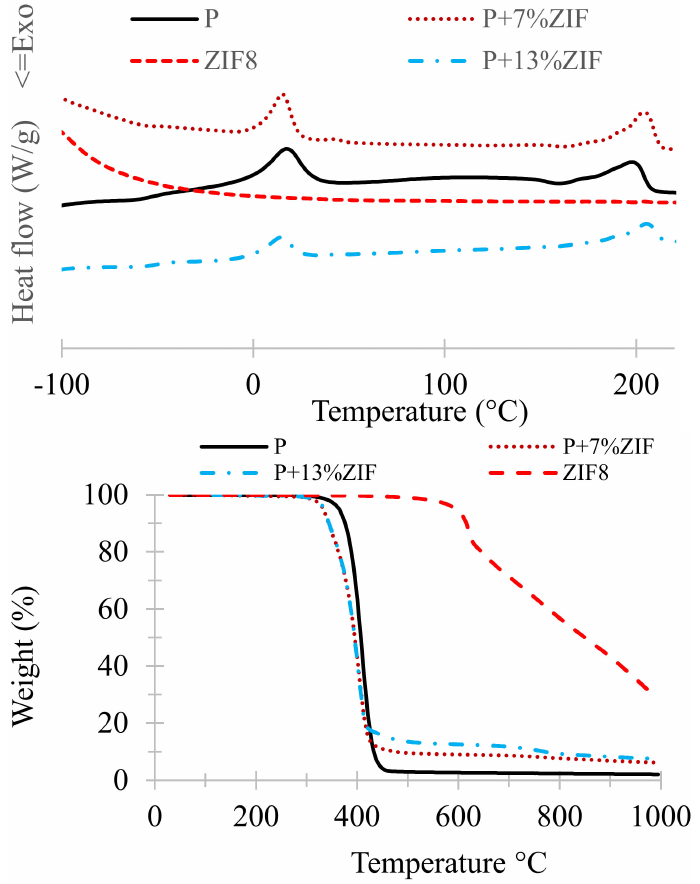
Figure 7. TGA and DSC curves of Pebax/ZIF-8